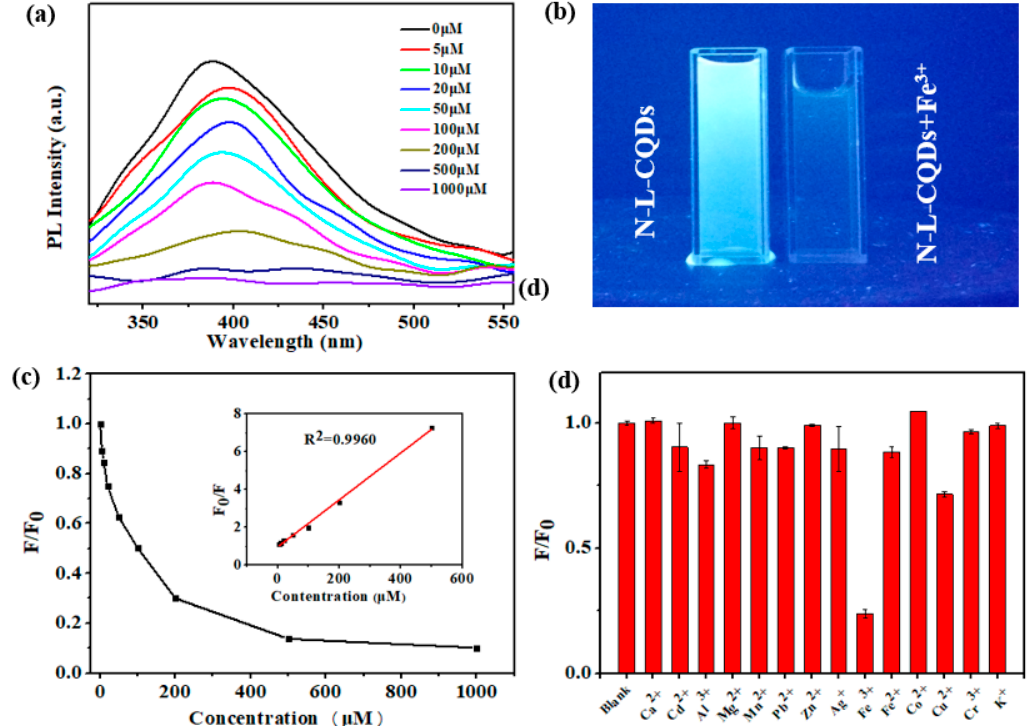
Figure 5. ( a ) Fluorescent emission spectra of N-L-CQDs quenched by Fe 3+ with various concentrations (from top to bottom: 0, 5, 10, 20, 50, 100, 200, 500, and 1000 μ M). ( b ) The photographs of N-L-CQDs aqueous solutions without (left) and with Fe 3+ under ultraviolet light (365 nm). ( c ) Relative PL intensity of N-L-CQDs in the presence of increasing concentration of Fe 3+ . Insert: a linear relationship of F 0 / F on the concentration of Fe 3+ ranging from 0 to 500 μ M. ( d ) Selective PL response of N-L-CQDs solution after added different metal ions with concentration of 200 μ M.